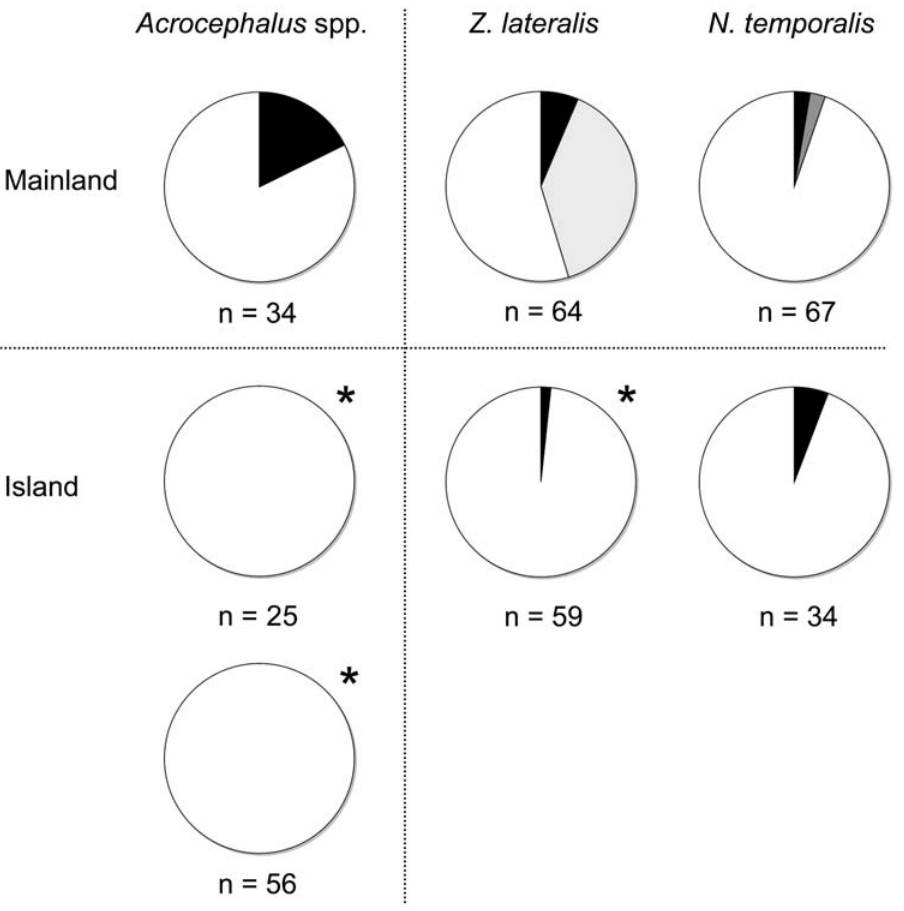
Figure 2. Prevalence of haematozoan parasites across mainland and island populations of Acrocephalusspp, Z.lateralis, and N.temporalis. Shading indicates the proportion of individuals infected with Plasmodium spp. (black), Haemoproteus spp. (light grey) and Leucocytozoon spp. (dark grey). Asterisks indicate significantly lower parasite prevalences in island endemic species ( Plasmodium spp. in A. aequinoctialis , above, and A. rimitarae , below) and recently introduced island populations ( Haemoproteus spp. in Z. lateralis ) relative to their mainland counterparts.